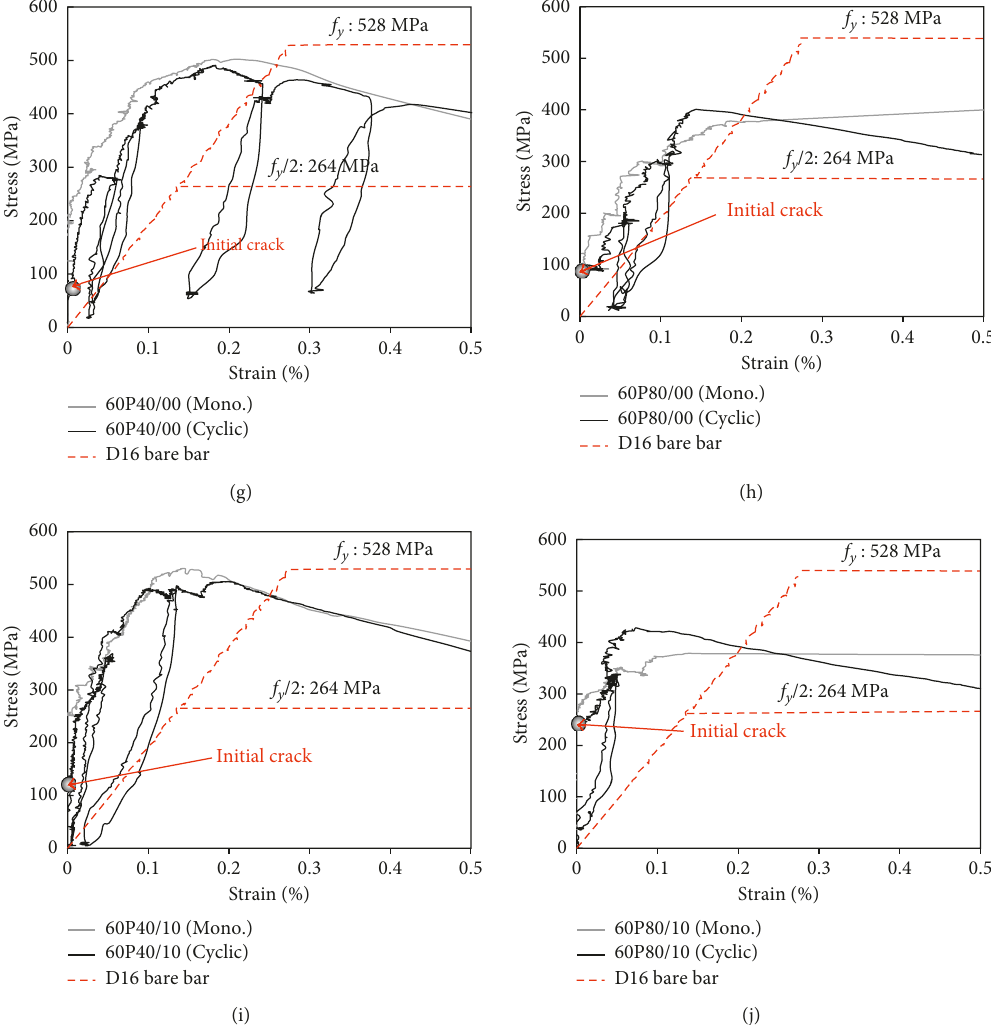
Figure 6: Tensile responses of lap splice specimens. (a) C40. (b) C80. (c) 40P40/00. (d) 40P80/00. (e) 40P40/10. (f) 40P80/10. (g) 60P40/00. (h) 60P80/00. (i) 60P40/10. (j)